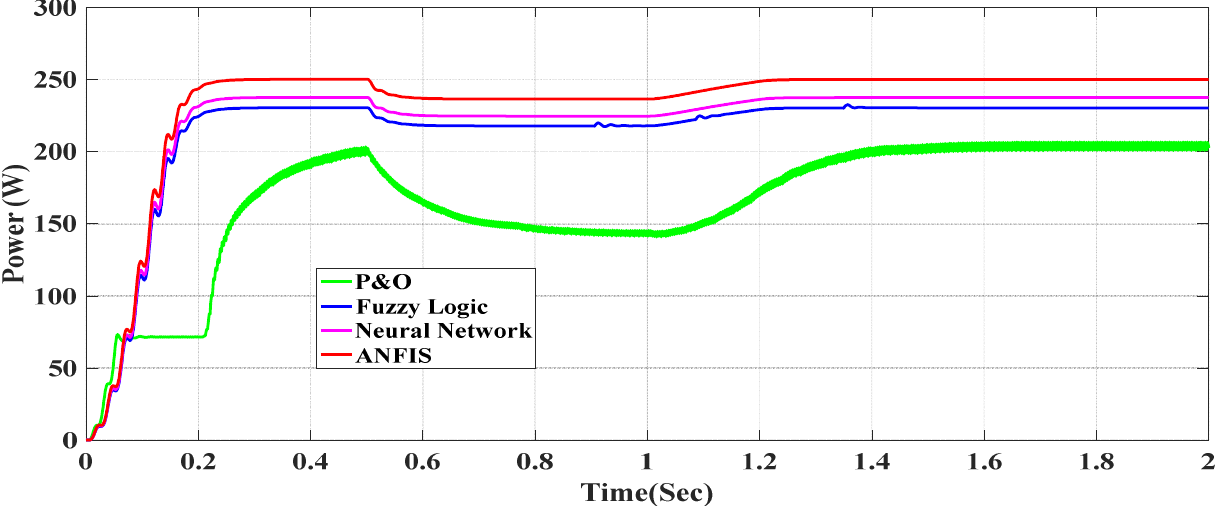
Figure 35. Output Power of PV framework using P-&-O, F-LC, AN-N and AN-FIS MPPT to the variation in SR.